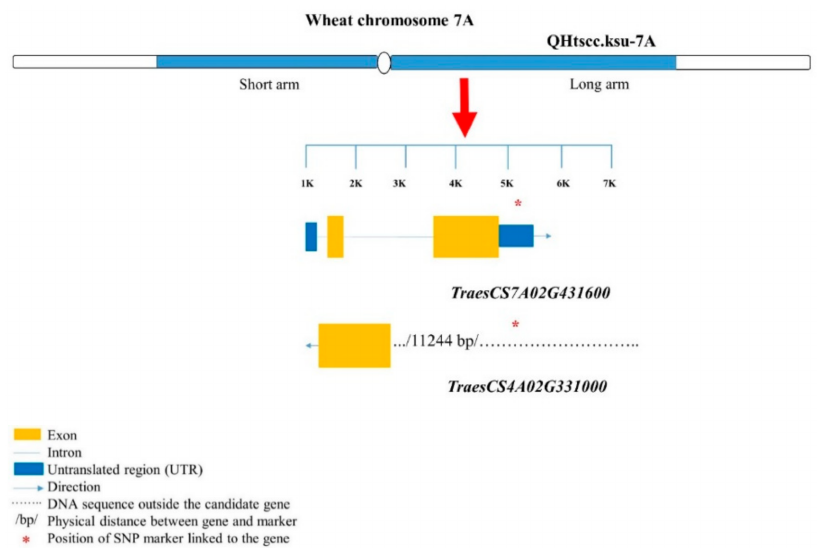
Figure 4. Structures of candidate genes in the QHtscc.ksu-7A genomic region (GR). The genes were identified based on the 90K wheat microarray assessment of near-isogenic lines with contrasting root traits. SNP markers are located in different positions of the genes. Structural information of the genes and SNPs was from a wheat genome database (https://urgi.versailles.inra.fr/jbrowseiwgsc/ gmod_jbrowse/, accessed on 2 March 2021). The physical positions of the linking markers of the QTL were found from the original mapping study using parental cultivar; therefore, in the reference genome (Chinese Spring), the QTL extends in both the long and short arm of chromosome 7A, which is unusual. Chromosomal fragment translocation might be the possible reason for the difference between the reference genome and the parental cultivars used in the original mapping study [25]. The measuring bar indicates the DNA length in kilo base pairs